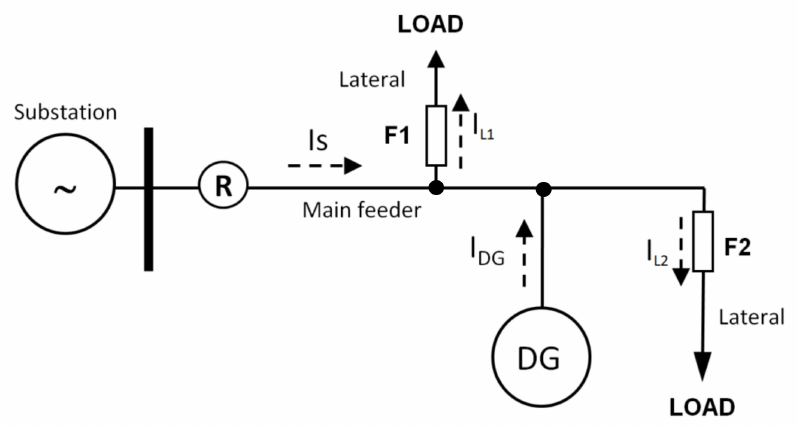
Figure 1. Basic topology of the simple power distribution network studied. A distributed generation (DG) source has been